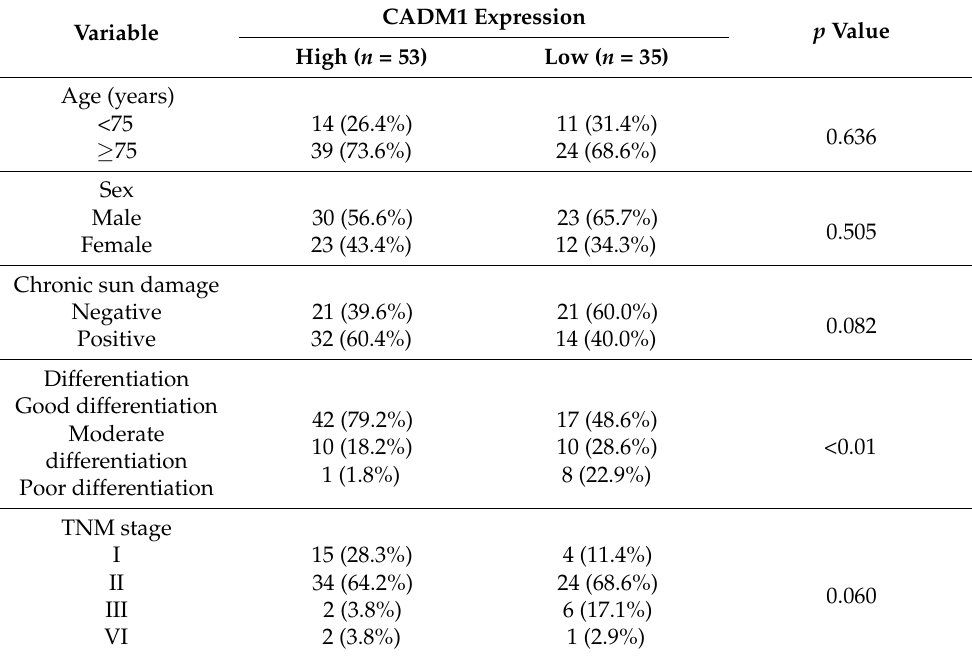
Table 2. Relationship between the CADM1 expression and clinicopathological variables of CSCC.